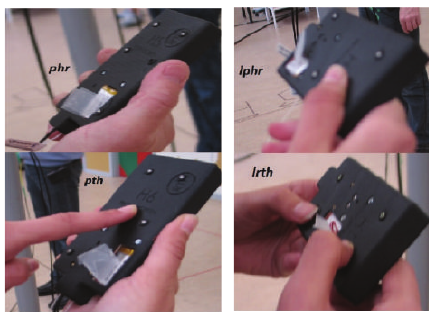
Figure 2: Different grips of